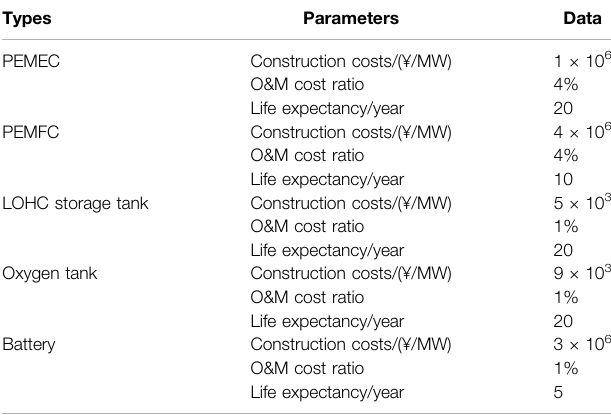
TABLE 2 | Related parameters of electricity-hydrogen coupling